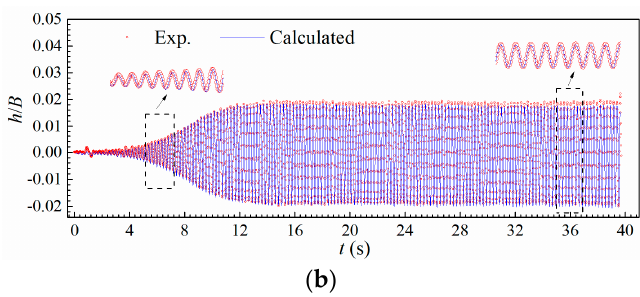
Figure 22. Comparison of tested and predicted ( a ) torsional and ( b ) heaving displacement during a post-critical LCO by the measured force signals (Case B1, U * = 7.785).